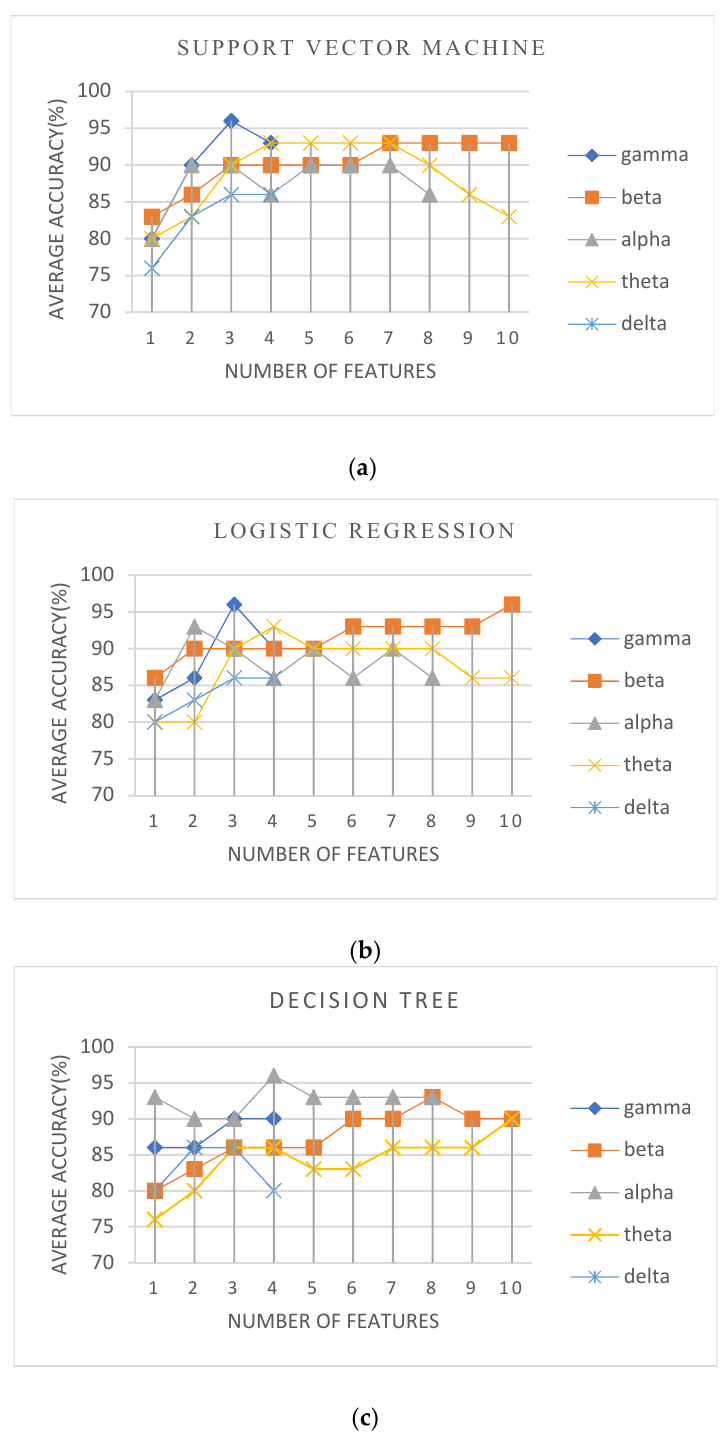
Figure 6. Averaged accuracy variations with the number of features selected by RFE for the ML classifiers for each sub-band. ( a ) support vector machine, ( b ) logistic regression, ( c ) decision tree.